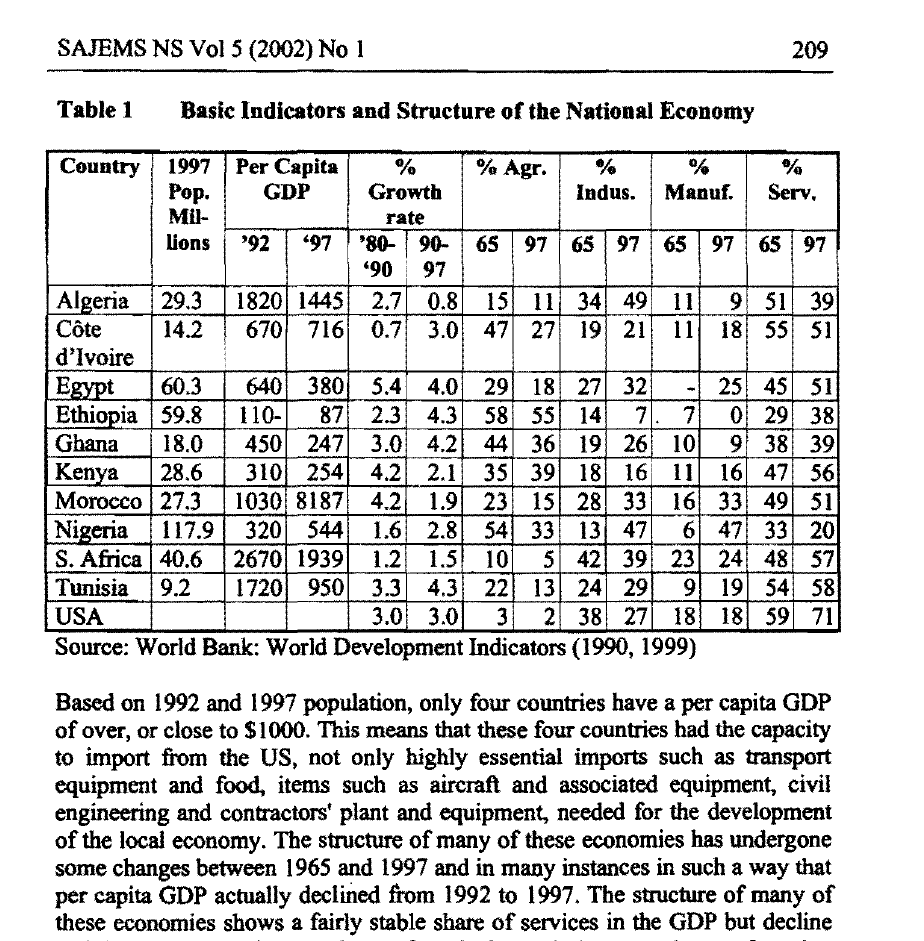
Basic Indicators and Structure of the National Economy